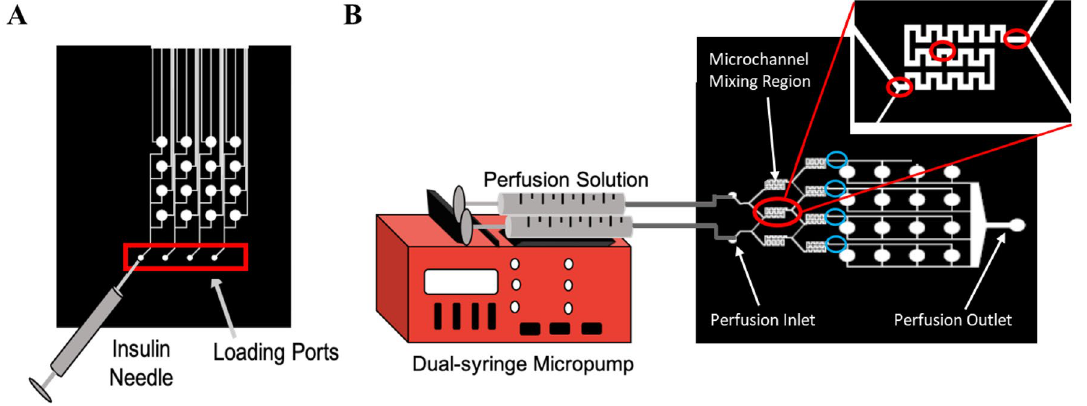
Figure 2. Loading and perfusion set-up. ( A ) Schematic of loading the hydrogel precursor solution into the membrane-capped microwells of the bottom loading layer of the device via the loading ports using an insulin needle. ( B ) Schematic of perfusion set-up in which tubing connects the 3 mL syringes containing the perfusion fluids to the inlet ports of the microfluidic device. Red circles indicate where images were taken within the micromixer for mixing analysis (entrance, middle, and exit). Blue circles indicate where images were taken at the end of the micromixer for concentration gradient